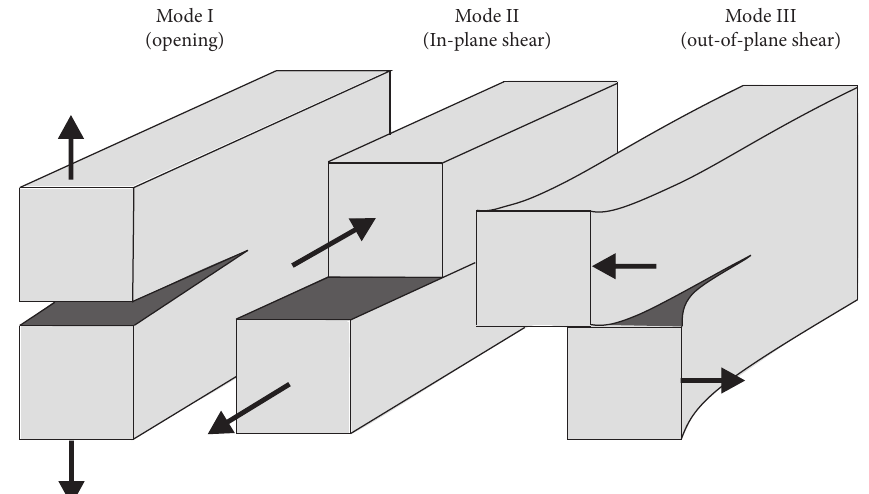
Figure 1: Three modes of crack due to loading